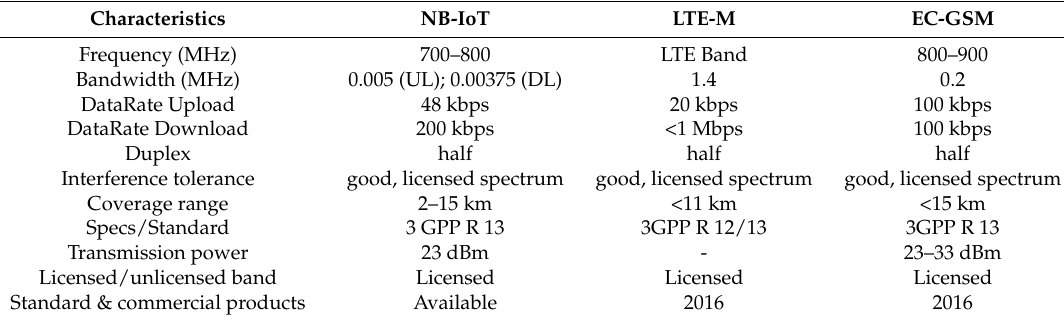
Table 4. Comparison of LTE-M, NB-IoT, and EC-GSM